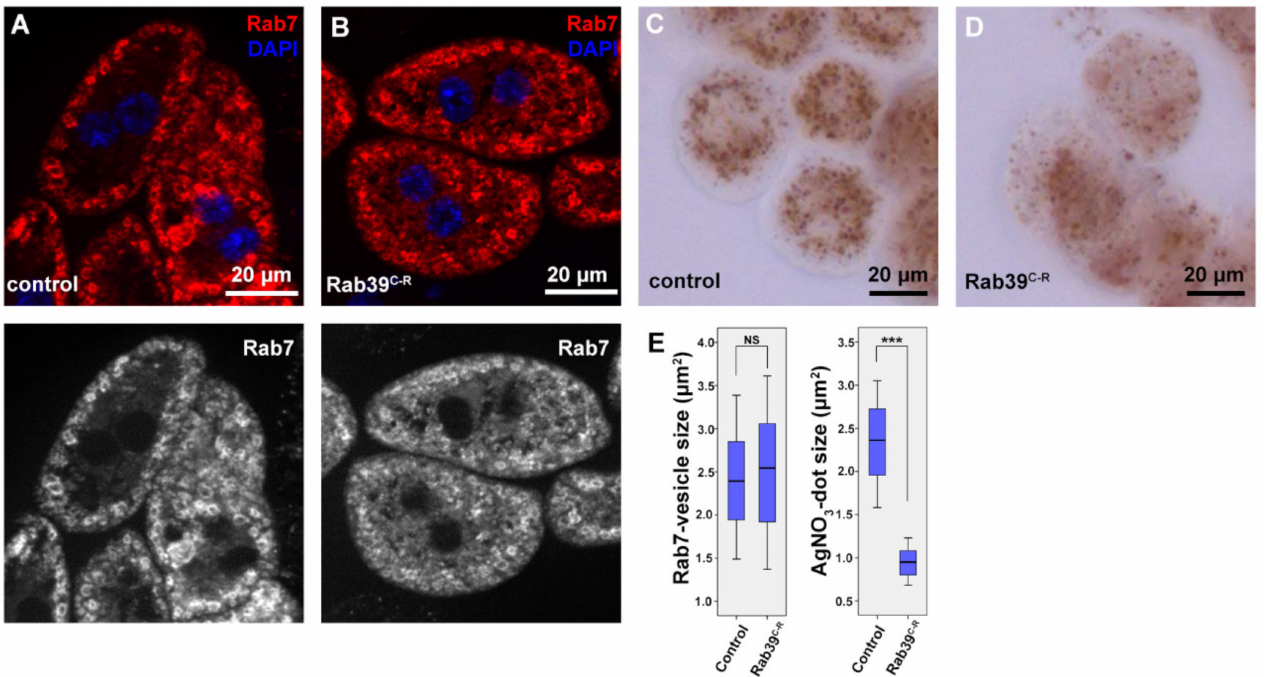
Figure 2. Endocytic uptake and maturation are unaffected in Rab39-depleted nephrocytes of L3 stage wandering larvae. ( A , B ) An immunostaining against late endosomal Rab7 was performed in control ( A ) and Rab39 C-R ( B ) cells. No visible alteration was detectable upon Rab39 deficiency, suggesting that endosomal maturation undergoes properly. The respective red channels are shown in grayscale. ( C , D ) Silver nitrate was taken up by control ( C ) or mutant ( D ) garland nephrocytes, where silver was detected in the form of a brown precipitate. Rab39 mutant nephrocytes could also incorporate silver nitrate, but in smaller vesicles, meaning that endocytic uptake is unaltered. ( E ) Quantification of the experiments depicted in ( A , D ), n = 10 cells. None of the samples showed Gaussian distribution. Medians are shown as horizontal black lines within the boxes. Bars show the upper and lower quartiles, and the whiskers plot the smallest and largest observations. NS: non-significant ( p ≥ 0.05), *** p < 0.001. Heterozygous Rab39 C-R animals in A, C, E were used as control